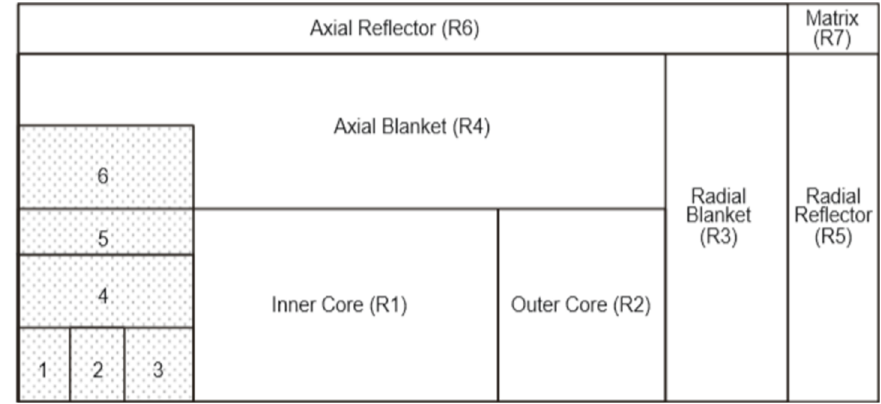
Figure 7. Arrangement of ZPPR-9 core fore sodium void reactivity evaluation.